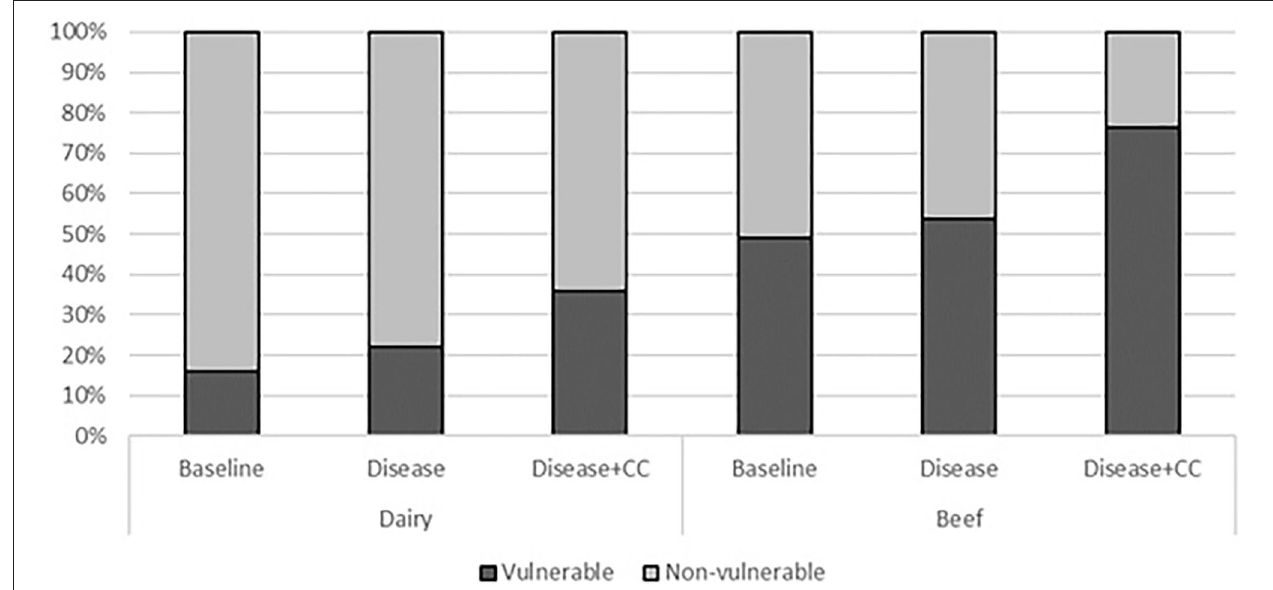
FIGURE 3 | Proportion of vulnerable and non-vulnerable dairy and beef farms (y-axis represents